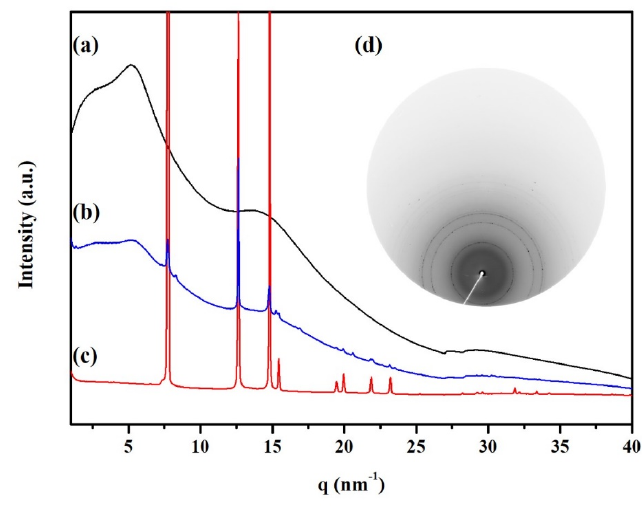
Figure 5. WAXS profiles of ( a ) PNIPAM-PA; ( b ) PNI-C 60 ; ( c ) C 60 and ( d ) Two-dimensional WAXS image of PNI-C 60 .